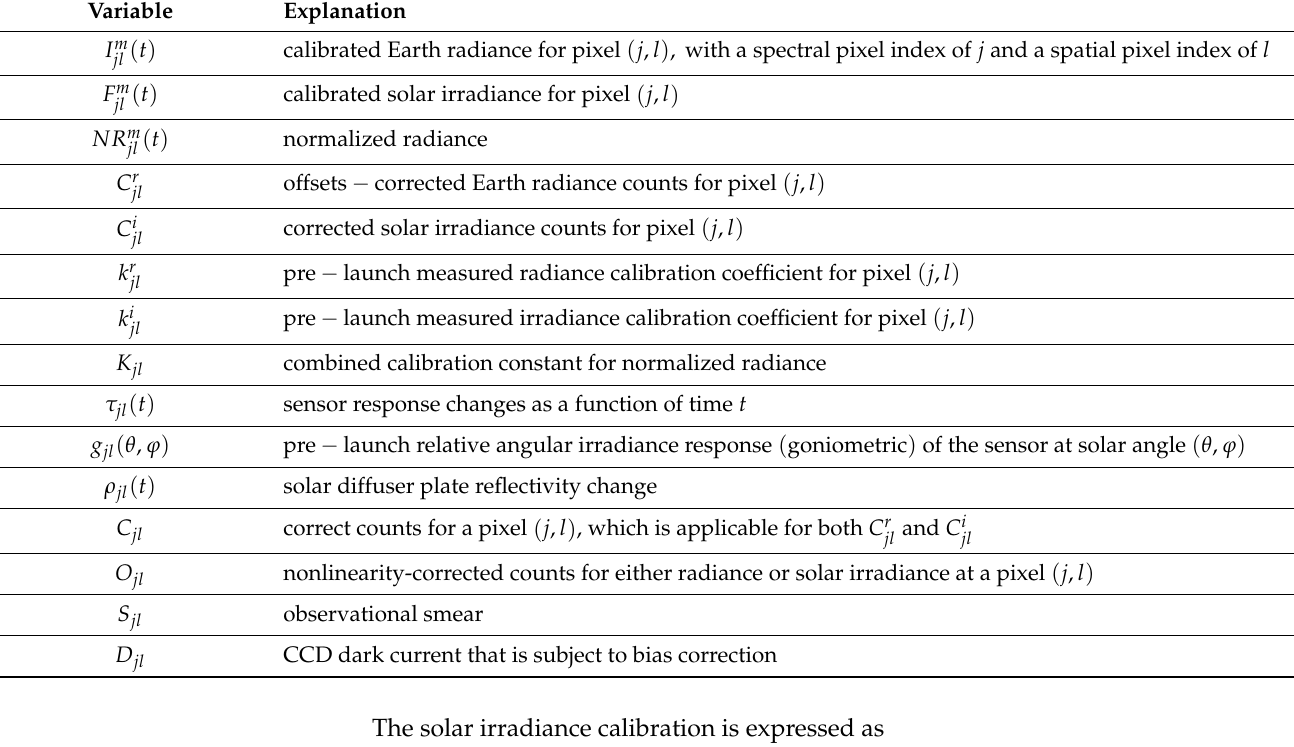
Table 2. Physical explanations of variables in (1) and other equations in this